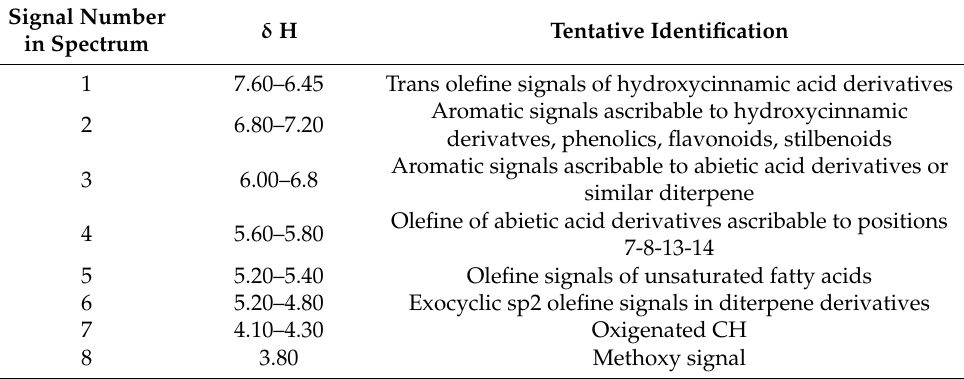
Table 2. Tentatively assignment of NMR signals ascribable to hydroxycinnamic esters, phenolics, abietanes. Signal